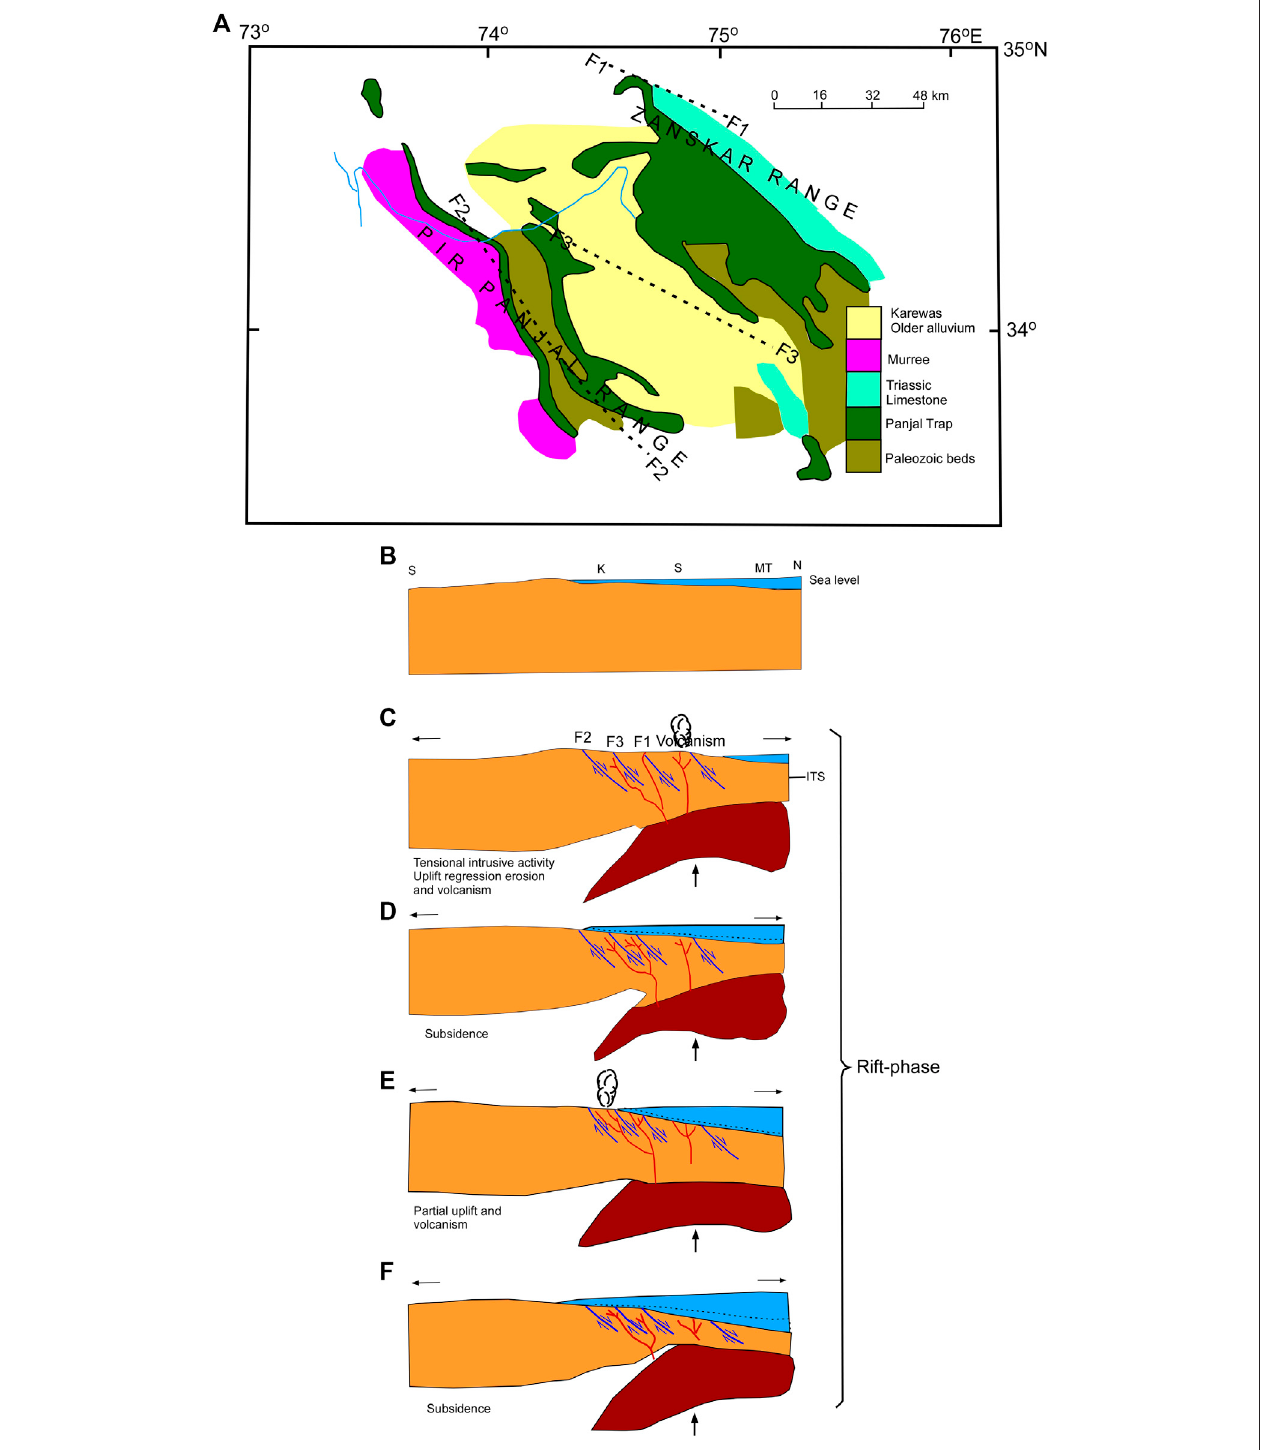
FIGURE 8 | The Kashmir basin as a product of tectonic rifting requires at least two major faults to pierce through the basin, and that will form a typical horst and graben topography (A) . The various stages of rifting and basin development are shown. The scenario before the basin development (B) , and after the fi rst episode of normal faulting and volcanism (C) . The faulting continued (D) with basin development as a result of subsidence during rifting. The partial uplift and new episode of volcanism (E) was followed by subsidence (F) , and basin development (after Bhat, 1982). ITS, Indus-Tsangpo Suture; K, Kashmir; MT, Main Tethyan basins; S,